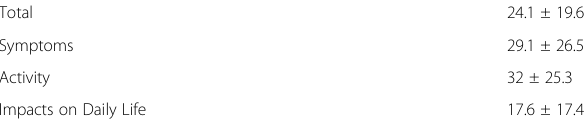
Table 77 (abstract A237). HRQL by